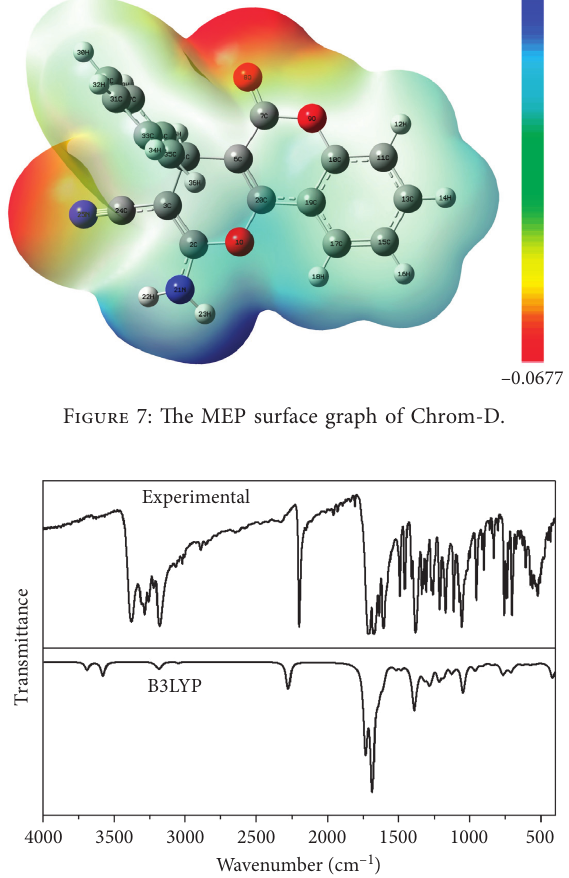
Figure 8: Experimental and theoretical FT-IR spectra of Chrom-D. Table 2: Experimental and calculated frequencies (cm − 1 ) using B3LYP/6-311++G(d, p) along with the vibrational assignments based on the percentage of the total energy distribution